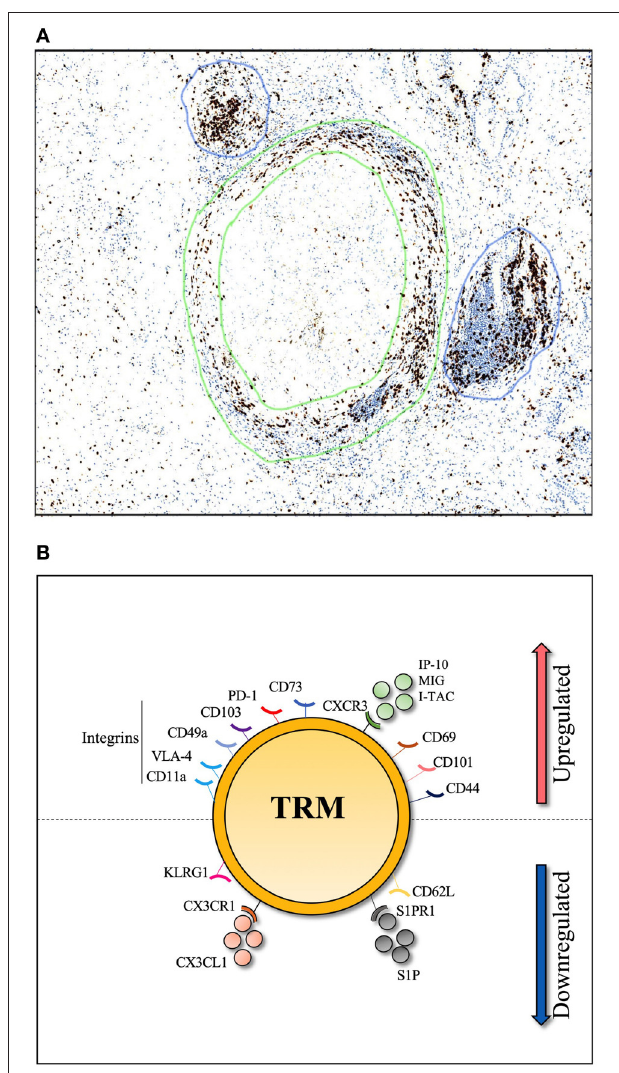
FIGURE 1 | Histological section of human TB lung granuloma. (A) 4 µ m section cut from a TB infected human lung removed by surgical resection to treat TB sequelae. Lymphocyte cuff of CD3 positive T-cells (stained in brown and shown by green circles) surround a core of CD68 positive macrophages, stained in a serial histology section (not shown), granuloma associated lymphocyte follicles indicated by blue circles. (B) Markers associated with lung Trm including integrins (CD11a, VLA-4, CD49a, and CD103), cell surface markers (PD-1, CD44, CD101, and CD69), chemokine receptor (CXCR3) and CD73 which is important for lymphocyte binding to the endothelium. To resist tissue exit cues, lung Trm cells downregulate expression of surface markers (CD62L, KLRG-1) and chemokine receptors (CX3CR1,